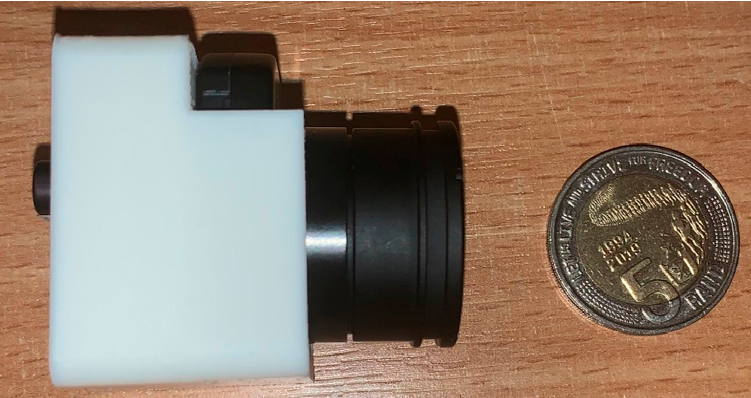
Figure 2 . FLIR Boson In a 3D printed case next to a coin for scale, the camera weighs around 7.5 grams.